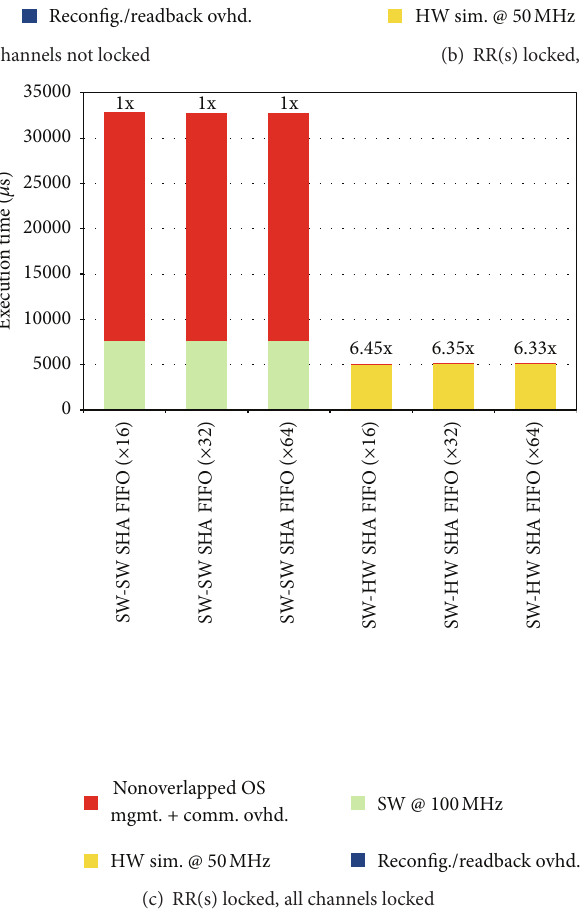
Figure 26: HW versus SW processing speedups for